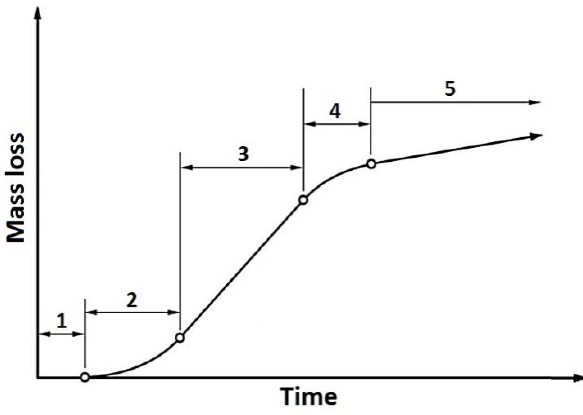
Figure 1. Evolution of LIE damage stages [4]. In sequential order: 1: incubation period; 2: acceleration period; 3: maximum rate period; 4: deceleration period; 5: terminal